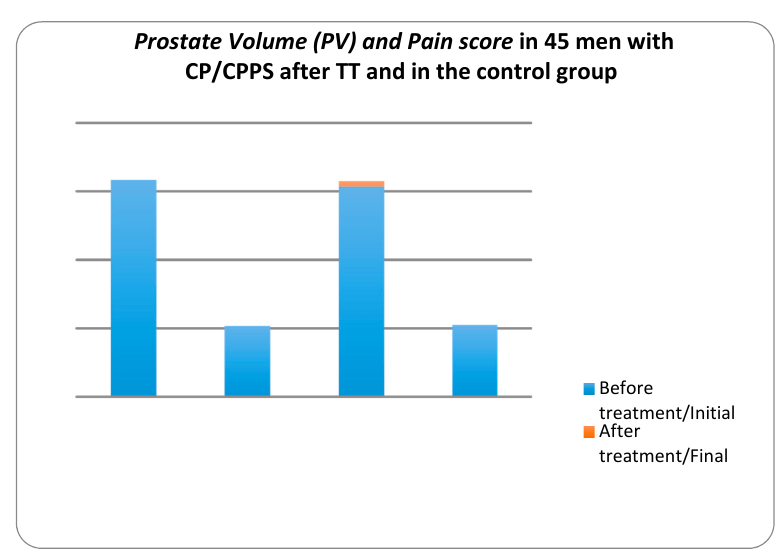
Figure 2. Dynamics of Pain scores and Prostate Volume (PV) mL in 45 men with CP/CPPS after TT and in the control group measured by the National Institute of Health-Chronic Prostatitis Symptom Index (NIH-CPSI) and ultrasound.